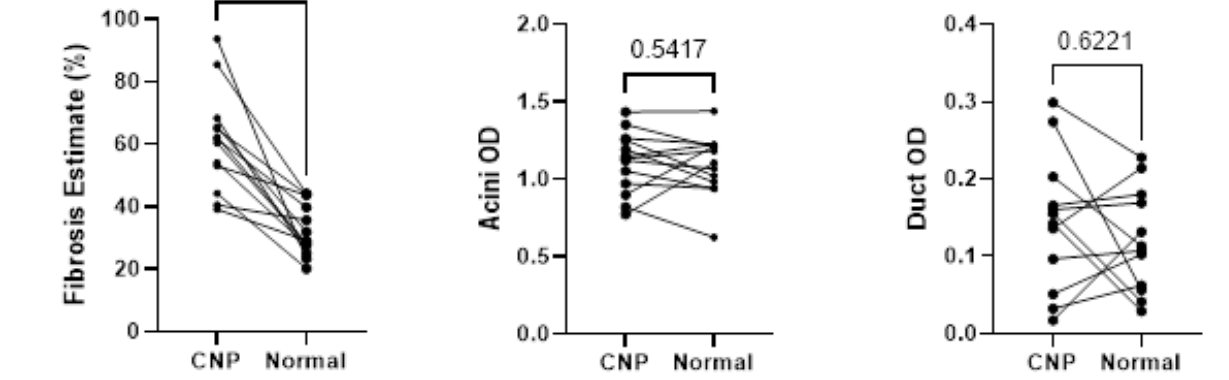
Figure 5. Wilcoxon testing comparing fibrosis, acini optical density, and duct optical density be- tween histologic designations of cases with both normal pancreatic tissue and chronic non-alcoholic pancreatitis tissues sampled. CNP, chronic non-alcoholic pancreatitis; OD, optical density.